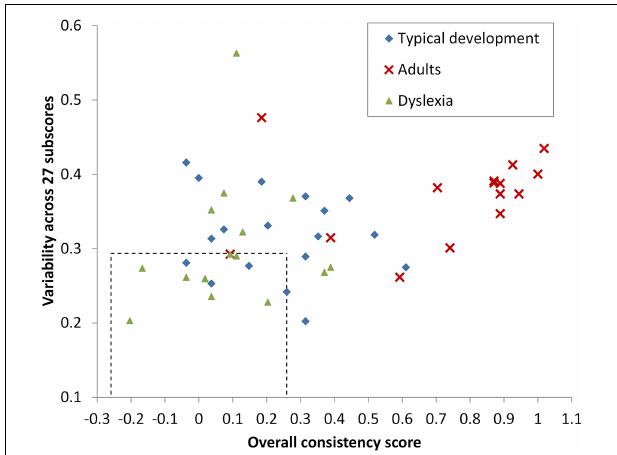
FIGURE 3 | Overall Consistency scores are plotted against performance variability, which was estimated as the standard deviation across 27 different subscores. Each dot corresponds to a participant. The dashed-outlined box shows the region where Monte Carlo-generated random performances fall with 95% probability on each